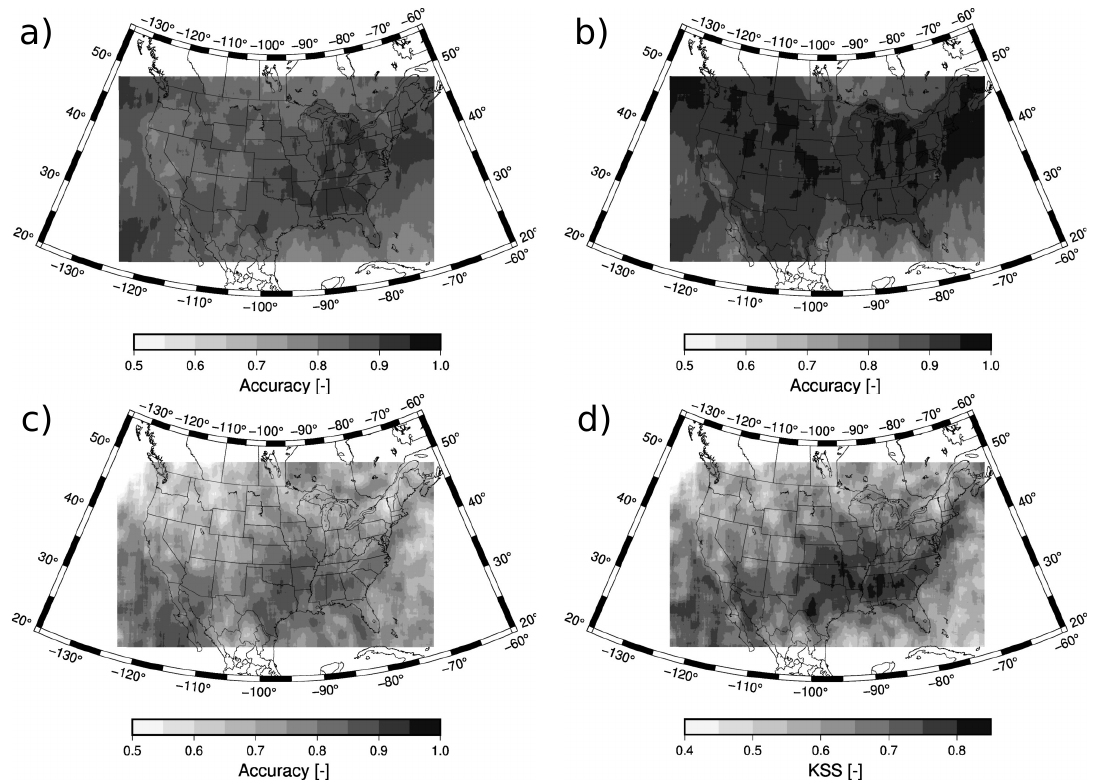
Figure 5. Accuracy for ( a ) all sky retrievals, ( b ) cloud detection, and ( c ) clear sky detection. The KSS is also shown ( d ). The values are calculated using data within 15 by 15 grid